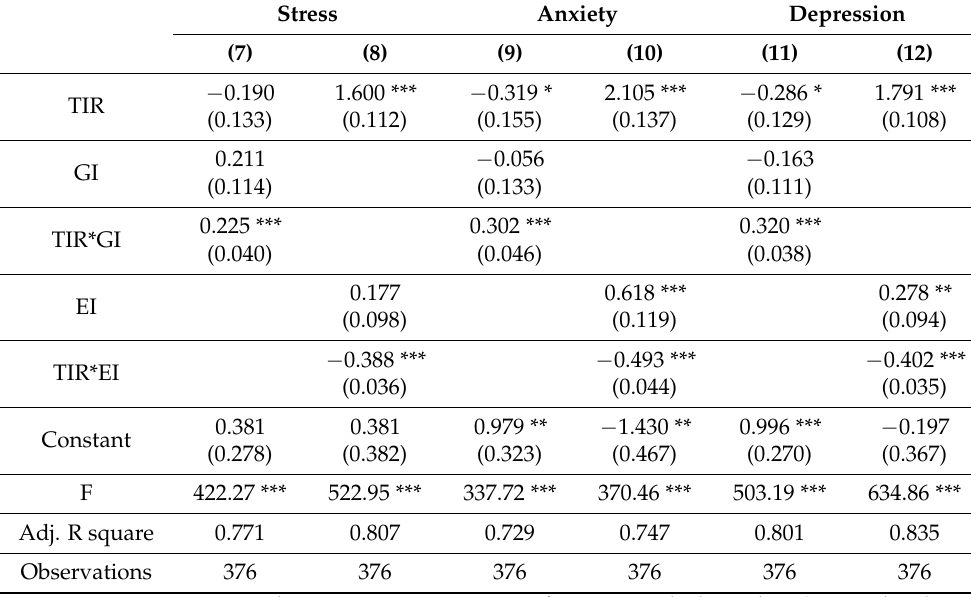
Table 6. Results of regression analyses for moderating